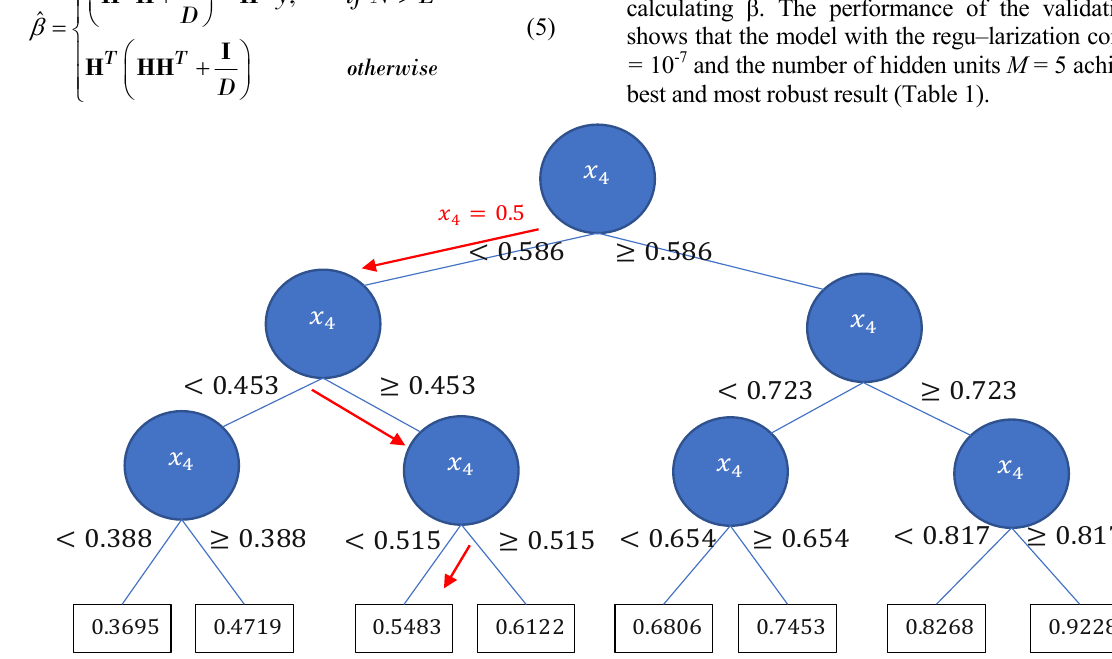
Figure 3. A trained regression tree sample with nodes (circle) and leaves (rectangle) Table 1 Preliminary experiments to determine RELM configurations